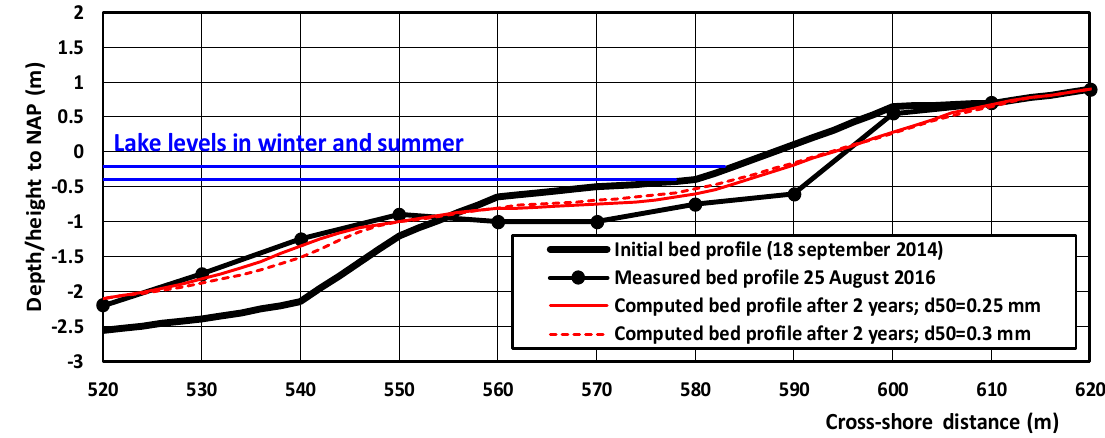
Figure 6. Computed beach profiles for daily wave conditions; validation case Crosmor-model.